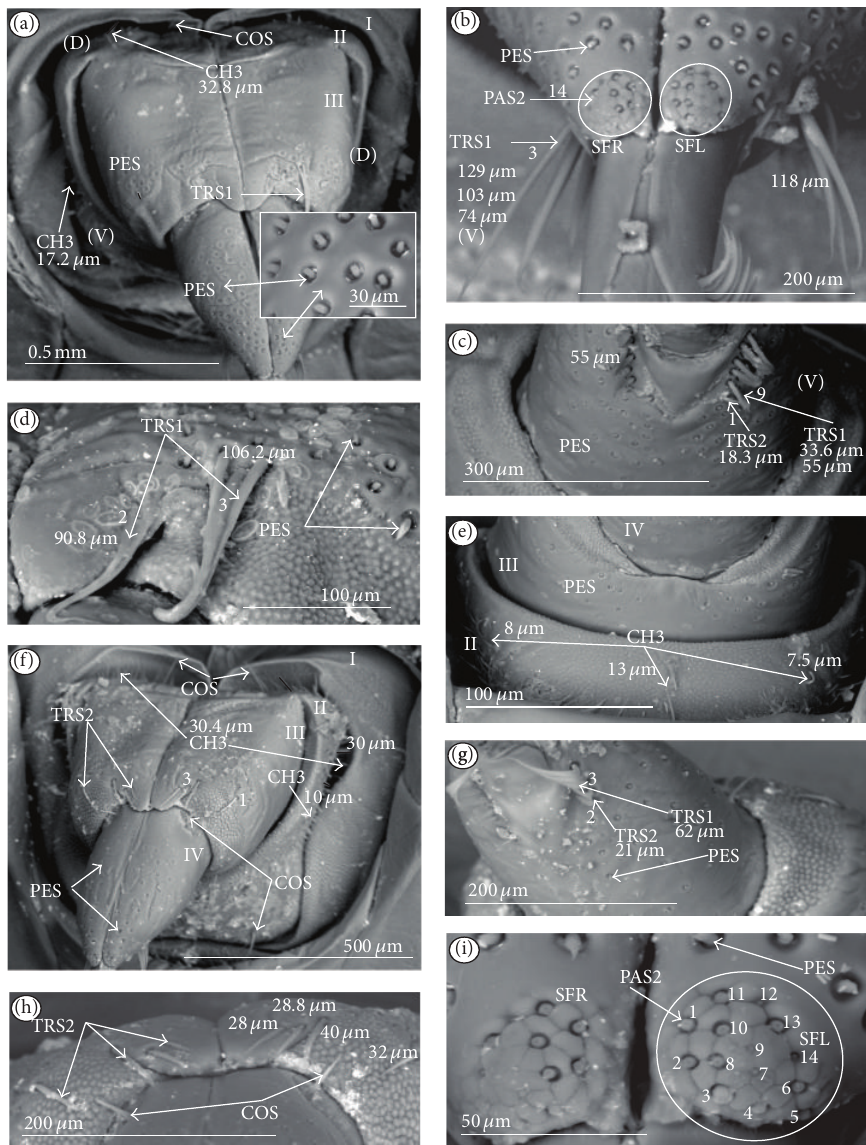
Figure 19: Types and sizes of the sensilla of the Naucoridae: Cheirochelinae ((a)–(e), Cheirochela feana , (f)–(i), Gestroiella limnocoroides ). (a) PES are numerous and distributed evenly on the IV segment (dorsal view), PES are present only in the distal area of the III segment, CH3 are less numerous and distributed over the II segment (dorsally and ventrally), and COS are situated on segment II (dorsal view). (b) PAS2 (no. 1–14) are distributed over SFL and SFR; TRS1 (three) are visible only ventrally (V) (the first specimen). (c) TRS1 (nine) and TRS2 (one) are distributed ventrally (V) near the apex of segment IV (the second specimen), and PES are numerous. (d) TRS1 are distributed in two tufts (2 + 3) on the distal edge of the III segment, and several PES are visible near the TRS1. (e) CH3 are sparsely distributed over segment II; several PES are visible on the III segment (ventral view). (f) PES are numerous and distributed evenly over the IV segment, TRS2 (four) are distributed separately (3 + 1) on the distal edge of the III segment, several PES are visible near TRS1, CH3 are less numerous and distributed over the II segment, and COS are situated on segments IV and II (ventral view). (g) TRS1 (three) and TRS2 (two) are distributed ventrally (V) near the apex of segment IV. (h) TRS2 and COS magnified. (i) PAS2 (no. 1–14) are distributed over SFL and